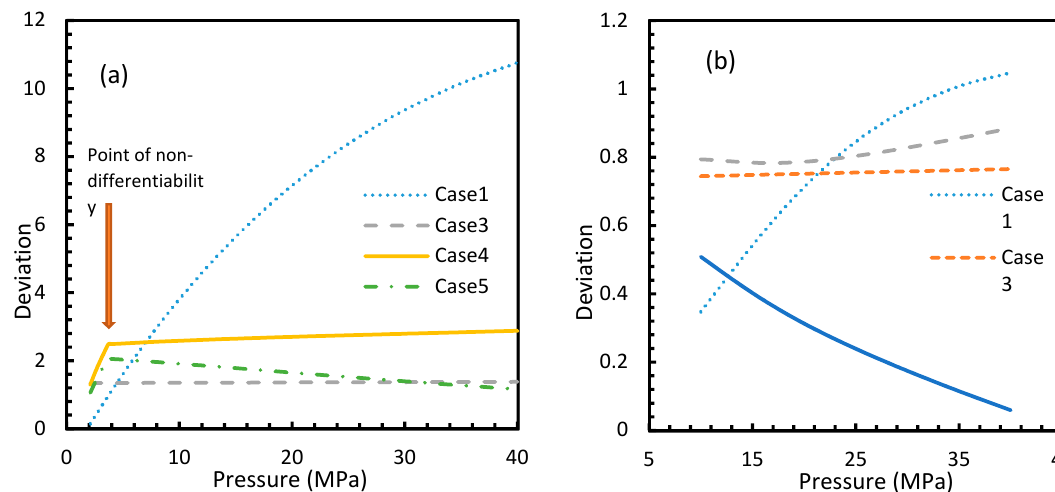
Figure 9. Deviation profiles for nucleation rates in Case 1 and Cases 3–5 of CO 2 ( a ) and CH 4 ( b ) from Case 2 under isothermal conditions with the reference temperature of 273.2 K. These profiles are observed to be the same as the profiles shown in dissolved concentration profiles.